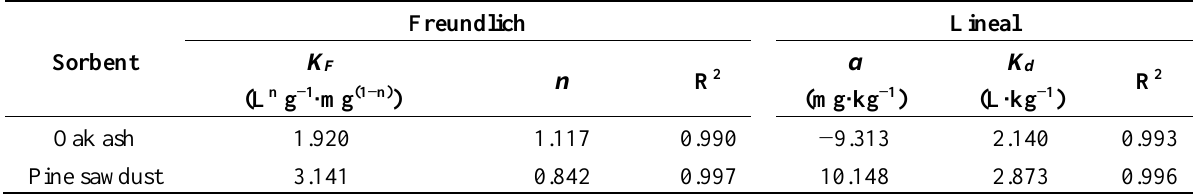
Figure 3. pH value in relation to the Cr adsorbed concentrations in oak wood ash and pine sawdust. Table 2. Constants and R 2 coefficients corresponding to the fitting of Cr sorption data to the Freundlich and Lineal models for oak wood ash and pine sawdust.